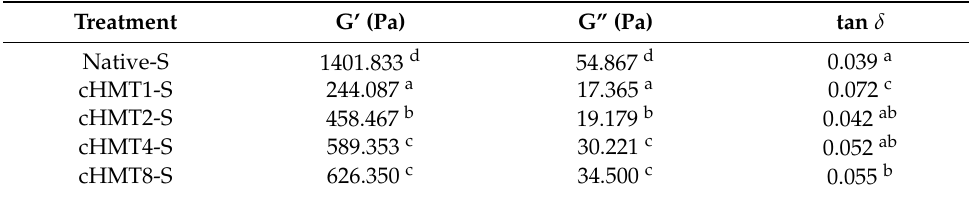
Table 4. Viscoelastic properties of native and cHMT water caltrop starch at 6.28 rad/s 1,2 .